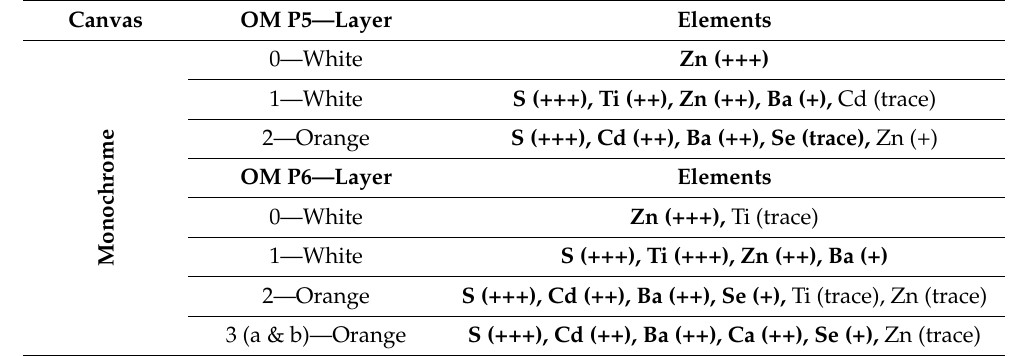
Table 3. Elements detected by EDX per layer on the cross-sectioned OM P5 and OM P6 samples. Main elements are written in bold. (+++ high, ++ moderate, + low concentration).